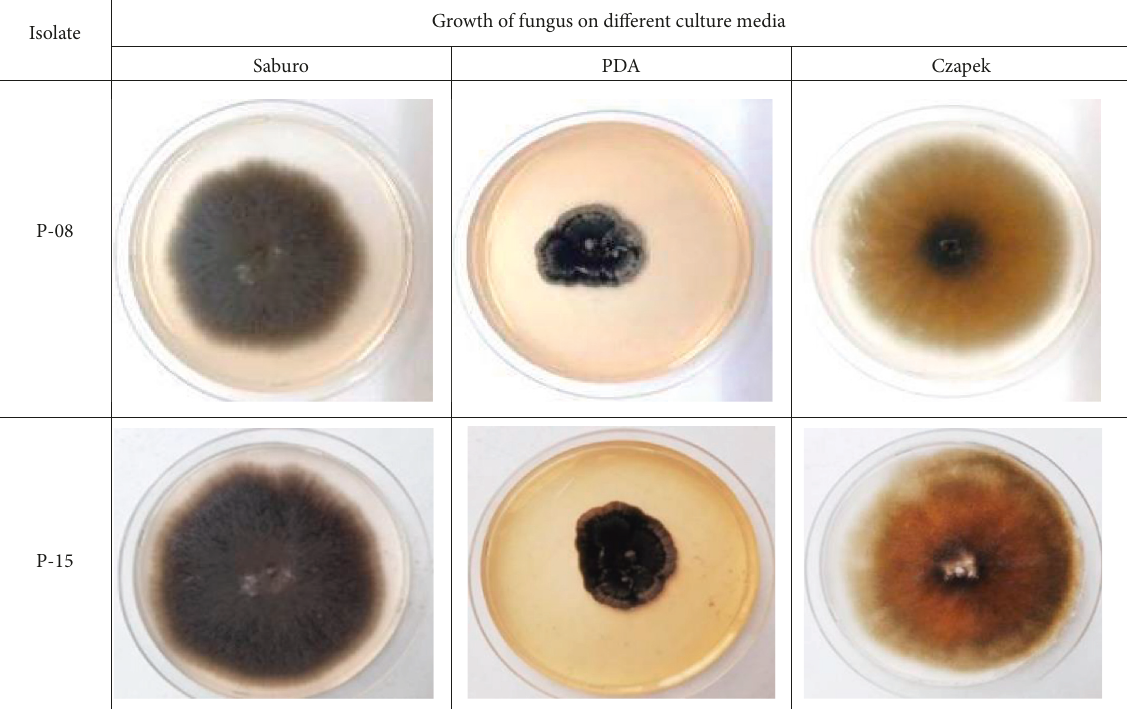
Figure 2: Cultures of the two identified B. sorokiniana isolates cultured on Saburo, PDA, and Czapek